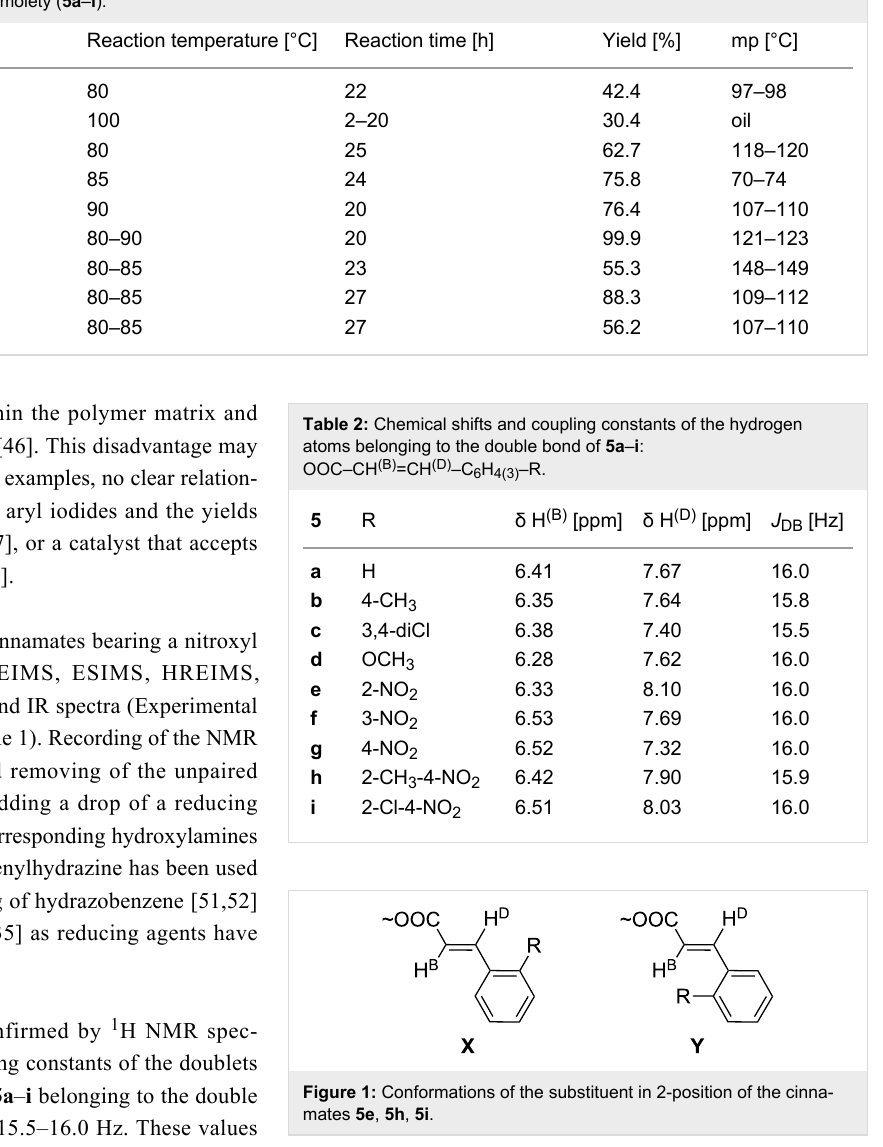
A molecular peak was present in all mass spectra of the synthe- sized products 5a – 5i . Except in the case of 5c , i it was clearly visible (5–25%). In all of the mass spectra, the abundant peak of the cinnamyl acyl cation ArCH=CHCO + was present. This was a base peak in the case of 5a,d